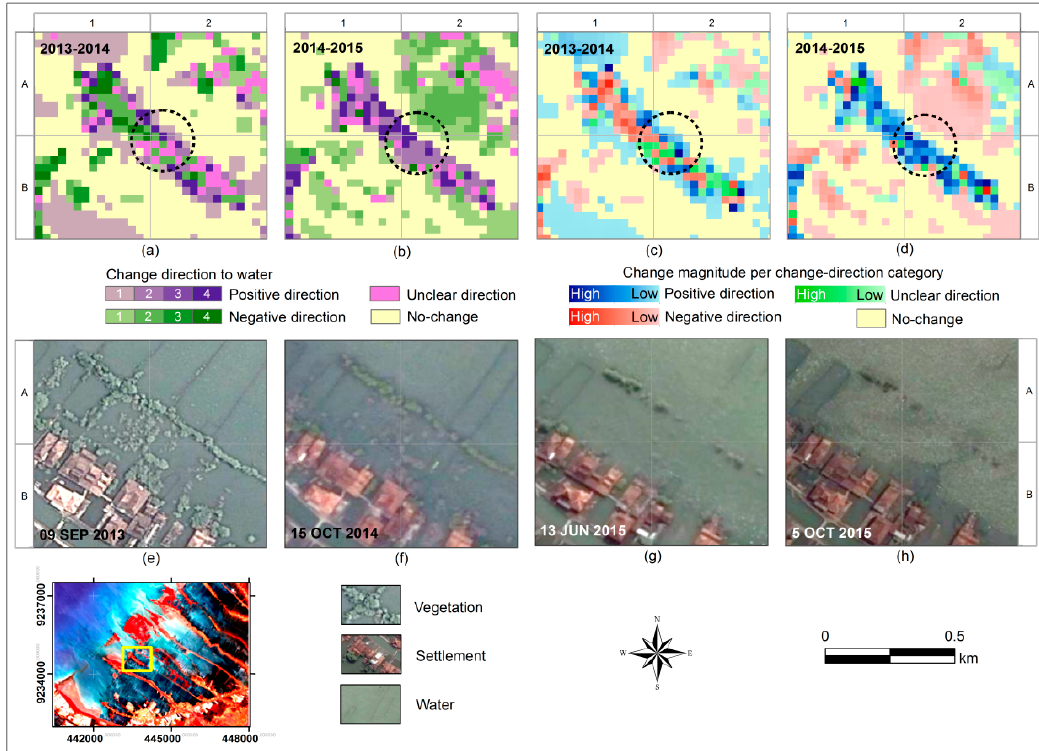
Figure 14. The location shows an unclear direction (see pink pixels in black-dashed circle in ( a )), while in the period 2014-2015 the location shows a low change to positive direction (light violet pixels in black-dashed circle in ( b )). The change magnitude values were low in the period 2013-2014 ( c ), while in the period of 2014-2015 the values were high (see dark blue pixels in black-dashed circle in ( d )). Images made available by Google Earth ( e – h ) show the decrease of mangrove coverage.